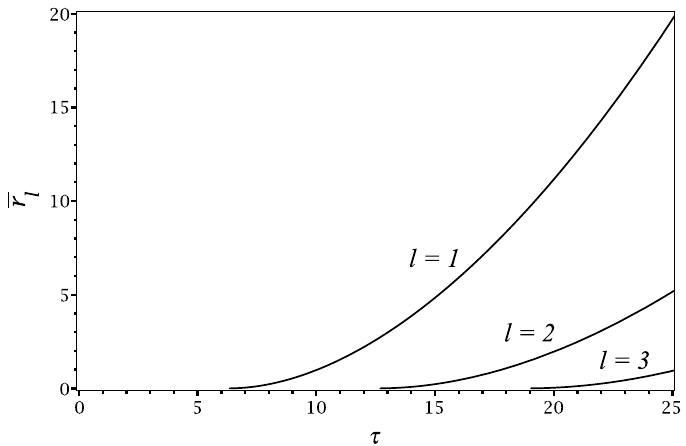
Figure 8. Evolution of the radial position of the (cid:96) th wave crest ¯ r (cid:96) in reduced units as a function of the reduced time τ based on the stationary phase method using the plasmon dispersion